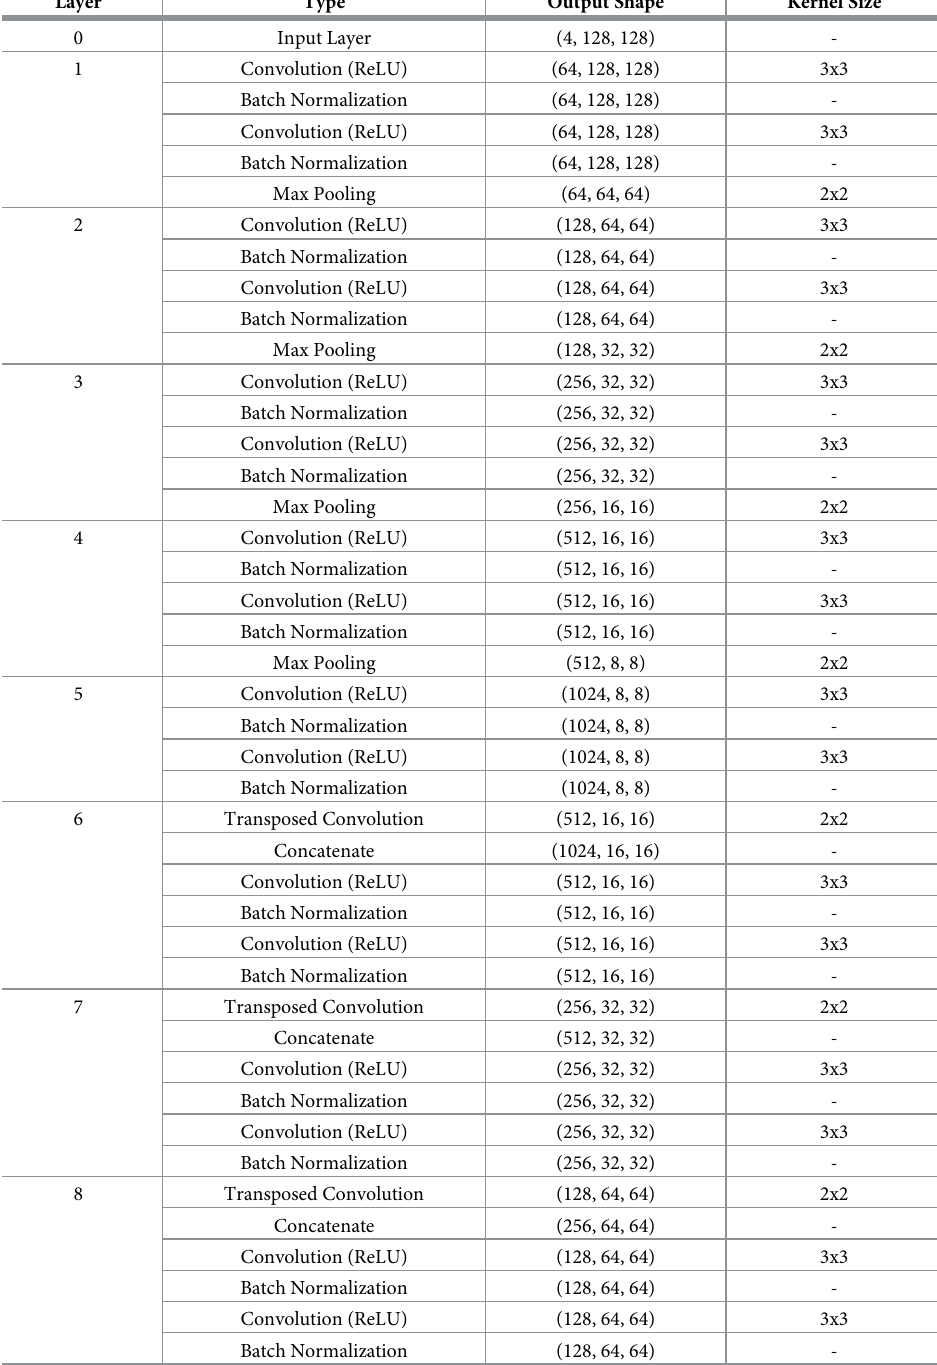
Table 6. 3D U-Net model structure for tumor